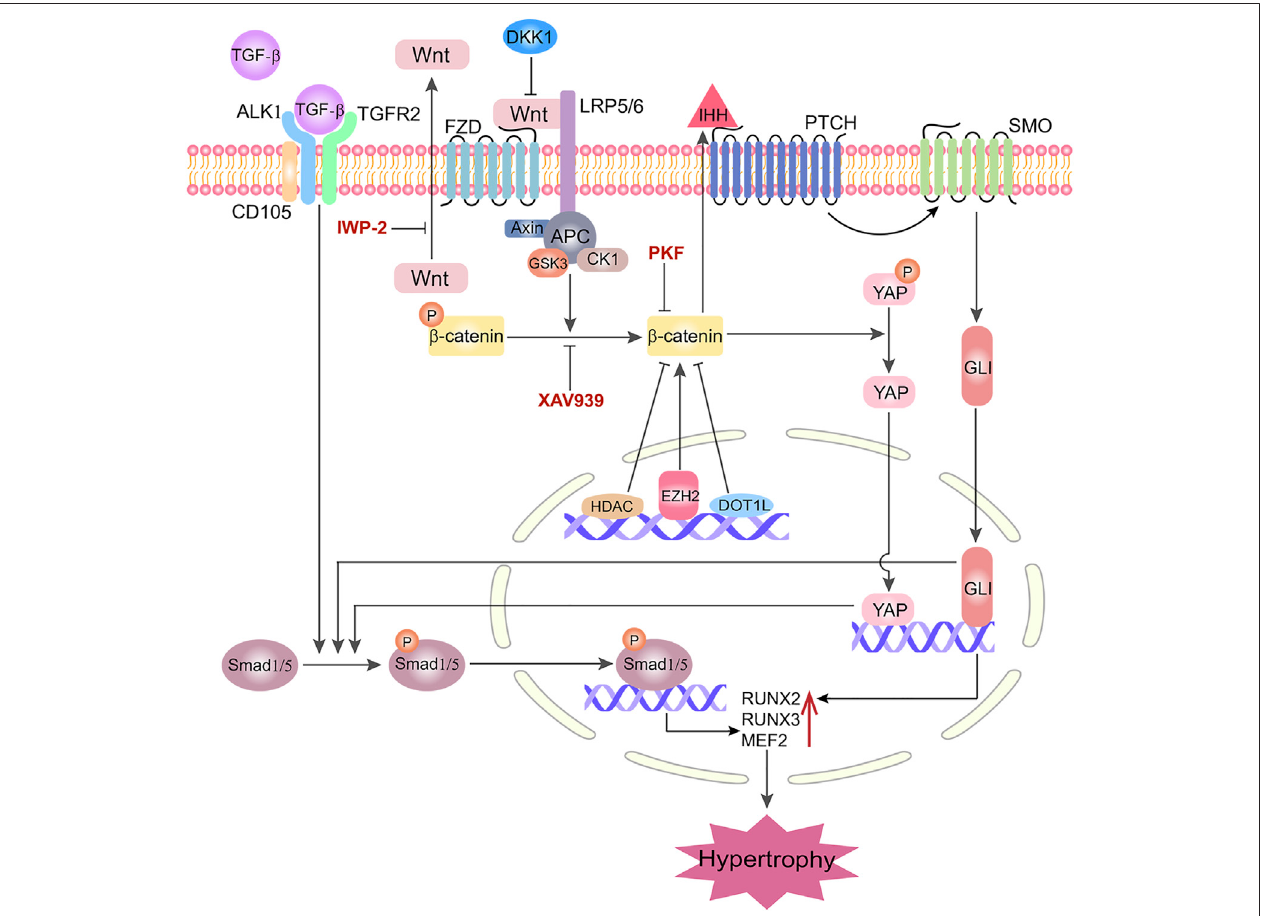
FIGURE 2 | Interactions of Wnt/ β -catenin signaling with other molecules/pathways in governing chondrogenic hypertrophy in MSC chondrogenesis. LRP5/6: Lipoprotein Receptor-Related Protein 5/6; FZD: Frizzled; ALK1: Activin Receptor-Like kinase 1; CD105: Endoglin; TGFR2: TGF-Receptor 2; PTCH: Patched; SMO: Smoothened; GlI: Cubitus interruptus; MEF2: Myocyte enhancer factor; DC: Destruction Complex; APC: Adenomatous Polyposis Coli; CK1: Casein kinase 1; GSK3: Glycogen synthase kinase 3; EZH2: Zeste homologue 2; DOT1L: Disruptor of telomeric silencing 1-like; HDAC4: Histone deacetylase 4; IHH: Indian Hedgehog; YAP:Yes-associatedprotein;SIRT1:Silentmatingtypeinformationregulator2homolog1;XAV939,IWP-2,PKFandDKK1arerepresentativeWnt/ β -catenininhibitorsin suppressing hypertrophy.